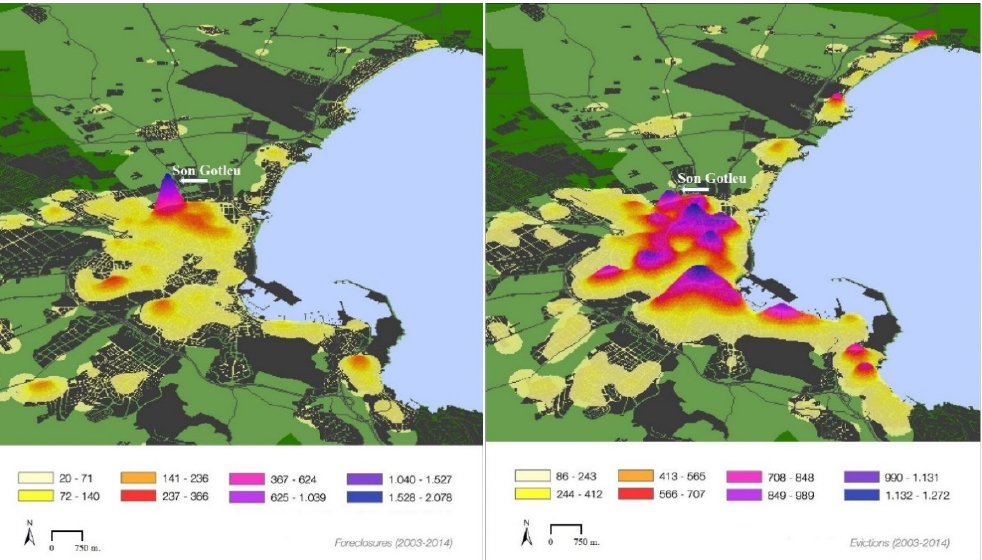
Figure 5. Spatial 3D representation of the number of foreclosures and rental evictions in the city of Palma (2003–2014). Source: Adapted from Vives-Mir ó , S., et al. (2018) [46], based on SCNE